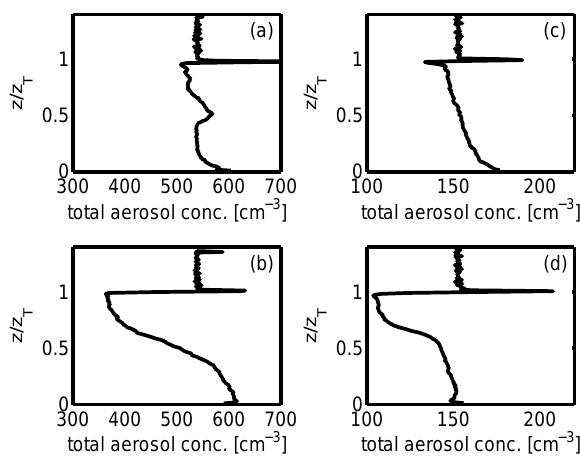
Fig. 13. Total aerosol concentration (ambient, interstitial and within droplets) predicted by the LCM after 2 h (top, a and c ) and 8 h (bottom, b and d ), as a function of height, scaled to the top of the cloud. HIGH aerosol case results are on the left and LOW aerosol case results are on the